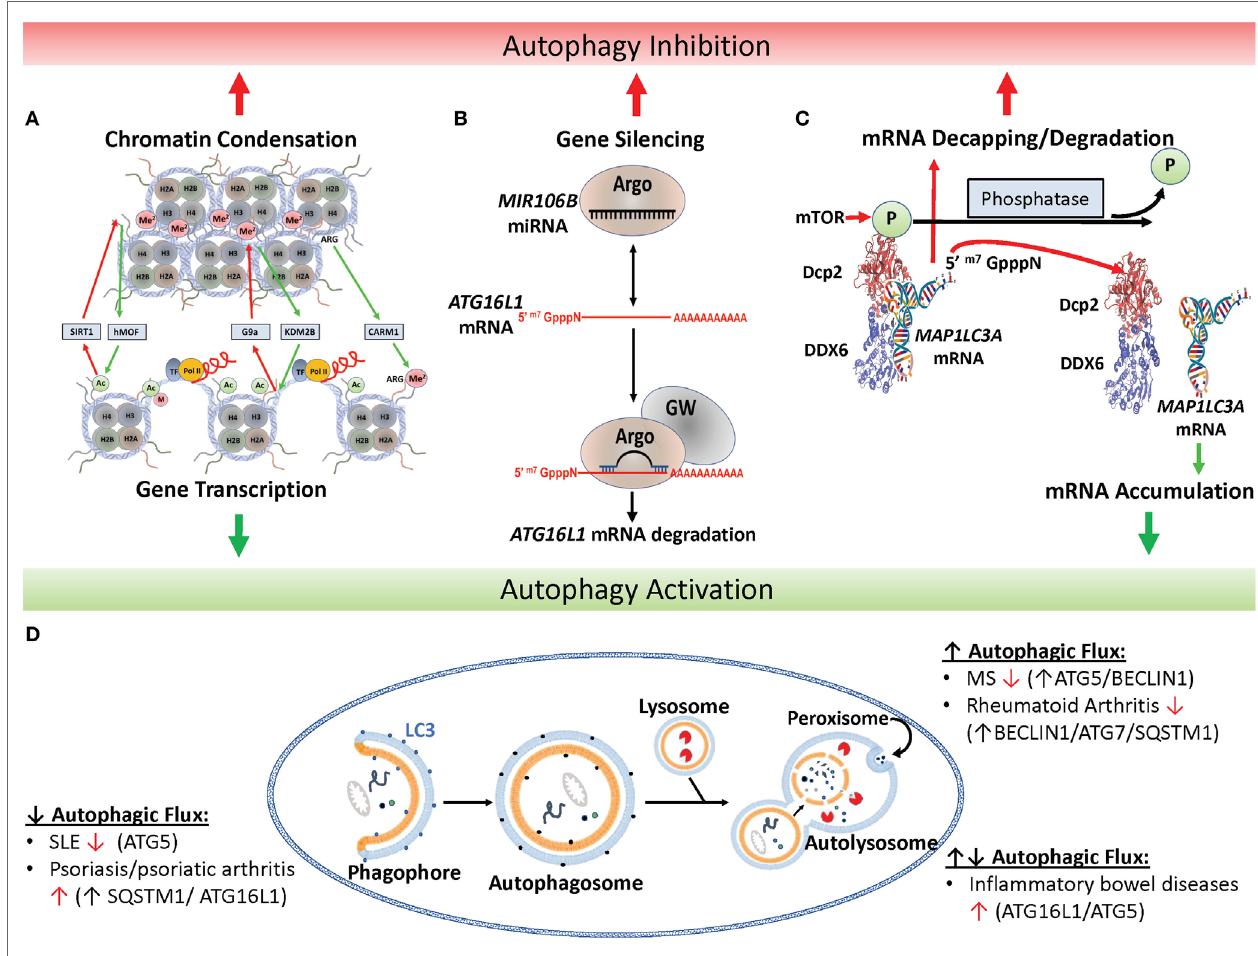
FiGURe 1 | Epigenetic regulation of autophagy. (A) Histone marks facilitate either chromatin condensation (top panel) or an open matrix which facilitates transcription (lower panel). Repressors include the histone deacetylase SIRT1, the H3 histone methyltransferase G9a and activators include the H3 histone acetyltransferase hMof, the H3 demethylase KMS2B and the H3 arginine methyltransferase co-activator-associated arginine methyltransferase 1 (CARM1). (B) Canonical microRNAs (miRNAs), such as MIR106B, is recruited to Argonaut members (ARG) which recruits target mRNAs, such as the autophagy-related ATG16L1 mRNA, for degradation and gene silencing in concert with GW-motif proteins (GW). (C) Mechanism of mTOR-dependent decapping/degradation. mTOR-dependent phosphorylation of the decapping protein DCP2 facilitates recruitment of target mRNA molecules for decapping followed by degradation. Conversely, low mTOR activities in the presence of phosphatases result in dissociation of the decapping complex from the mRNA target with resultant accumulation of target transcripts, illustrated here with the autophagy-associated transcription, MAP1LC3A. [Model of putative mammalian DCP2-DDX6 interaction with MAP1LC3A mRNA adapted from Ref. (16).] (D) Illustration of autophagy and autoimmune diseases associated with alterations in autophagic flux. In autophagy, protein aggregates, misfolded proteins, and pathogens are recruited to the phagophore and then enclosed by a double-membrane vesicle to form the autophagosome. Following lysosome fusion with the autophagosome, proteinaceous material undergoes degradation in the autolysosome. Red arrow found next to autoimmune disease names indicates whether disease improves ( ↑ ) or declines ( ↓ ) following pharmacological inhibition of autophagy